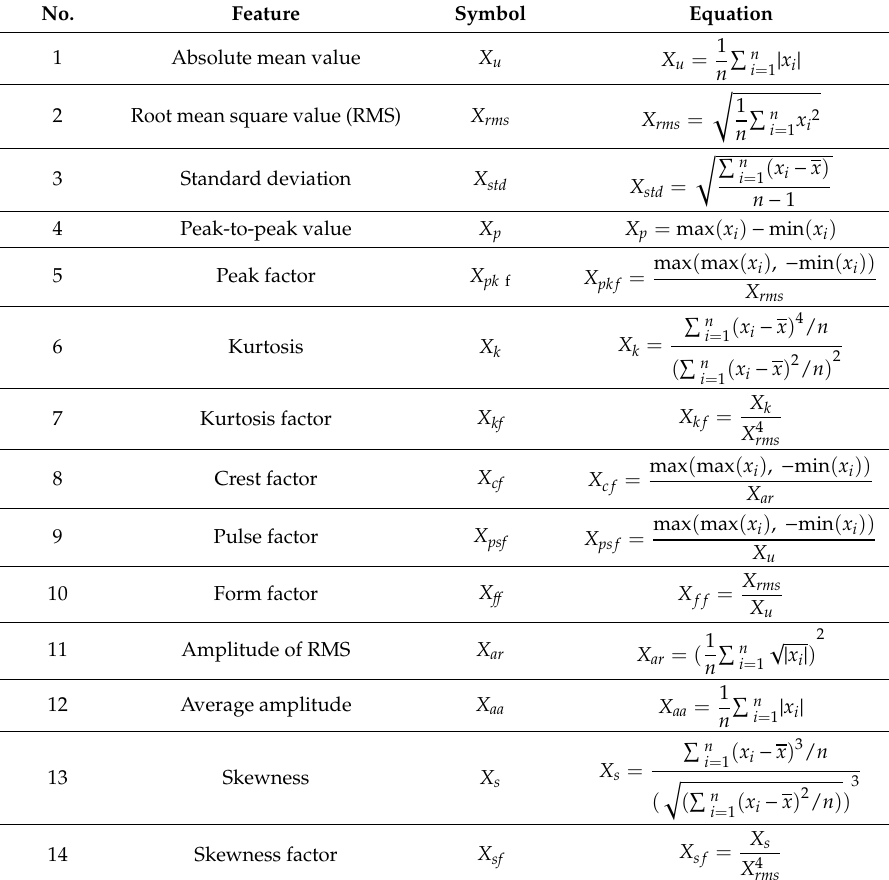
Table 1. Statistical